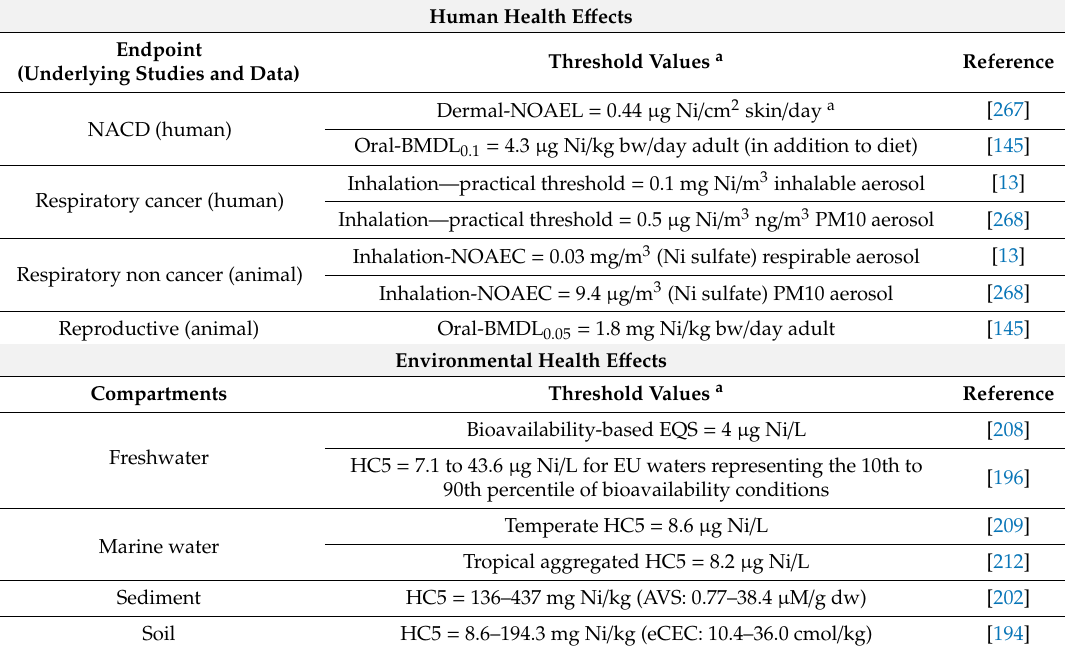
Table 2. Thresholds for nickel toxicity corresponding to the main routes and health e ff ects of concern to human health and for the main environmental